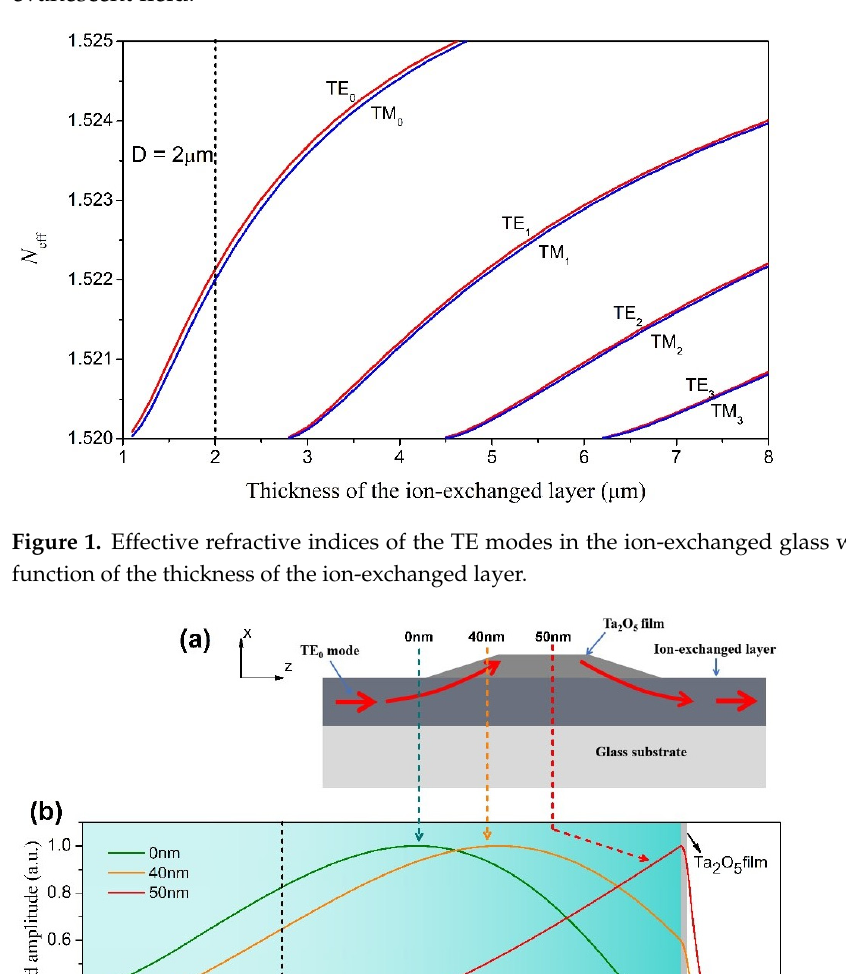
Figure 1. Effective refractive indices of the TE modes in the ion-exchanged glass waveguide as a function of the thickness of the ion-exchanged layer.